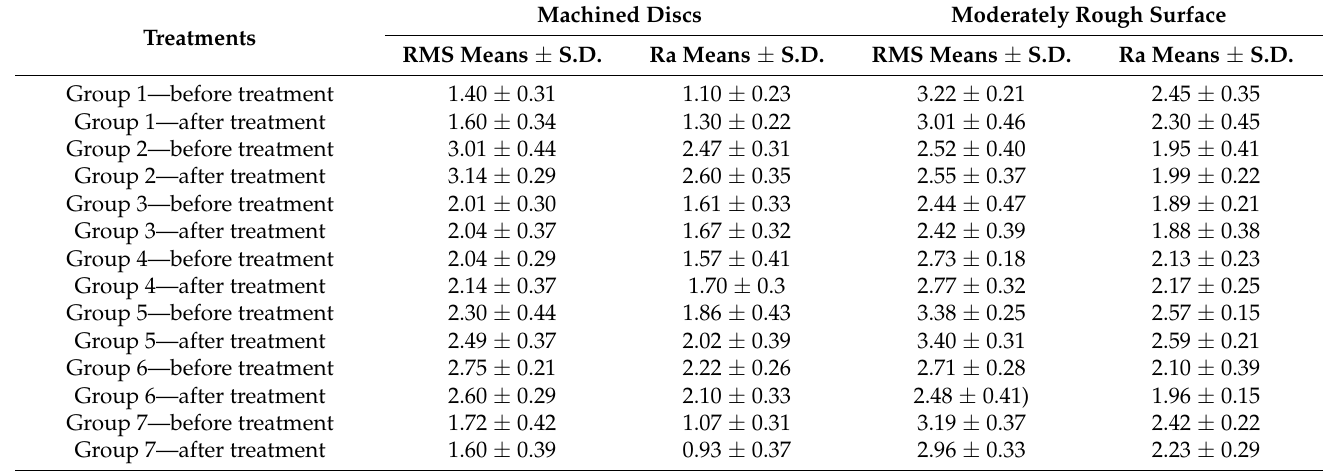
Table 1. Evaluation of RA (roughness average) and RMS (root mean square) before and after treatment with different powders, expressed as means and standard deviations (S.D.) for machined surface and moderately rough surface